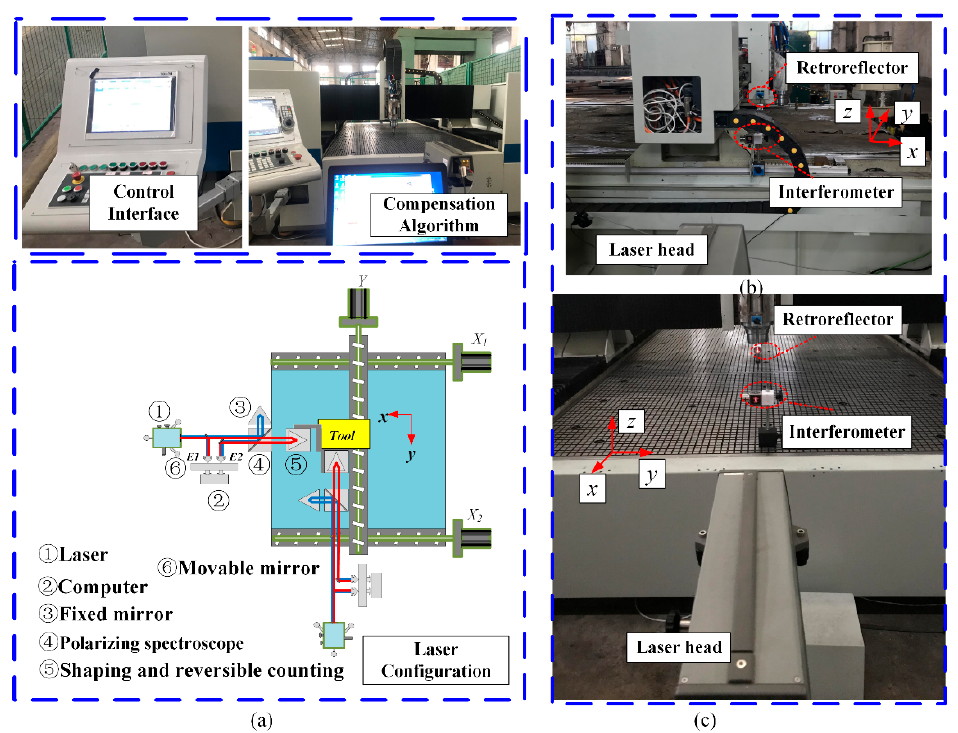
Figure 15. Error compensation experiments. ( a ) The measurement principle of tool center positioning errors; ( b ) error compensation with the tool center moving along the Y -direction; ( c ) error compensation with the tool center moving along the X -direction.